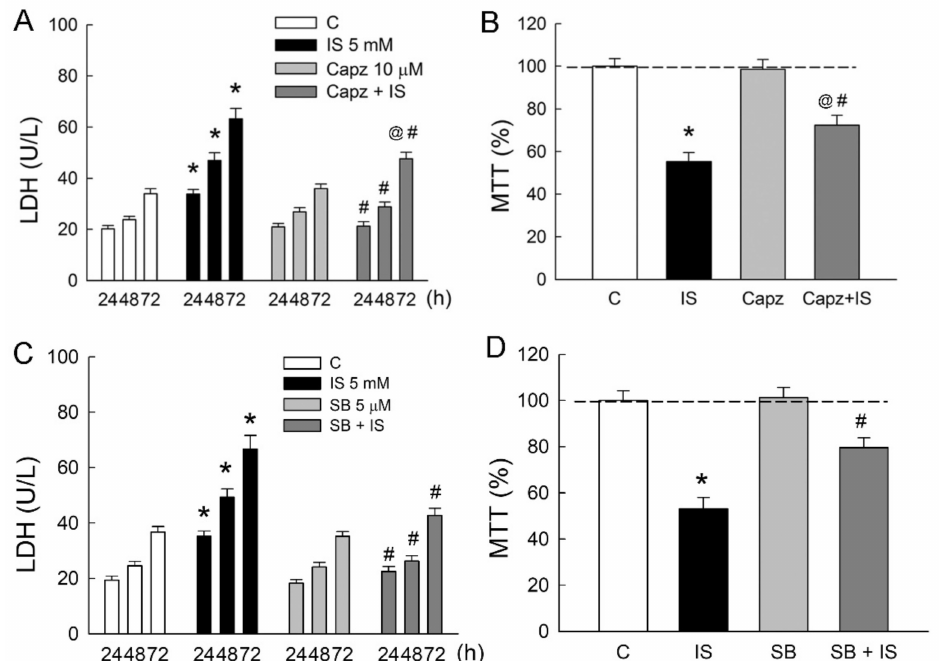
Figure 3. Blockade of TRPV1 attenuates indoxyl sulfate-induced tubular cell damage. MDCK cells were treated with a selective TRPV1 blockers capsazepine (Capz, 10 µ M), SB-366791 (SB, 5 µ M), or indoxyl sulfate (IS, 5 mM) alone or in combination for 24, 48, and 72h. ( A , C ) Lactate dehydrogenase (LDH) was determined as a marker of cell injury; ( B , D ) Cells were cultured for 72h in the presence of the indicated agents, and the viability was measured in an MTT assay. n = 6 of experiments performed in each time point of the group. * p < 0.05 versus the control group (C), @ p < 0.05, Capz (or SB) + IS versus Capz (or SB) group, # p < 0.05, Capz (or SB) + IS versus IS